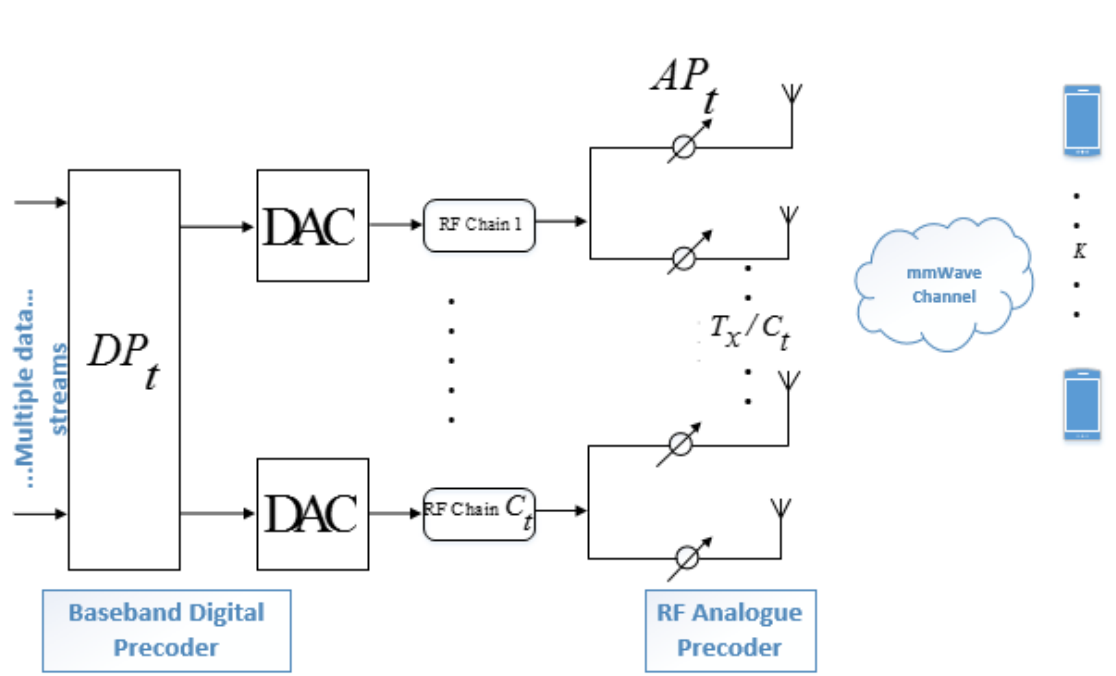
Figure 1. Conventionally used RF circuit configuration of mmWave Massive MIMO.